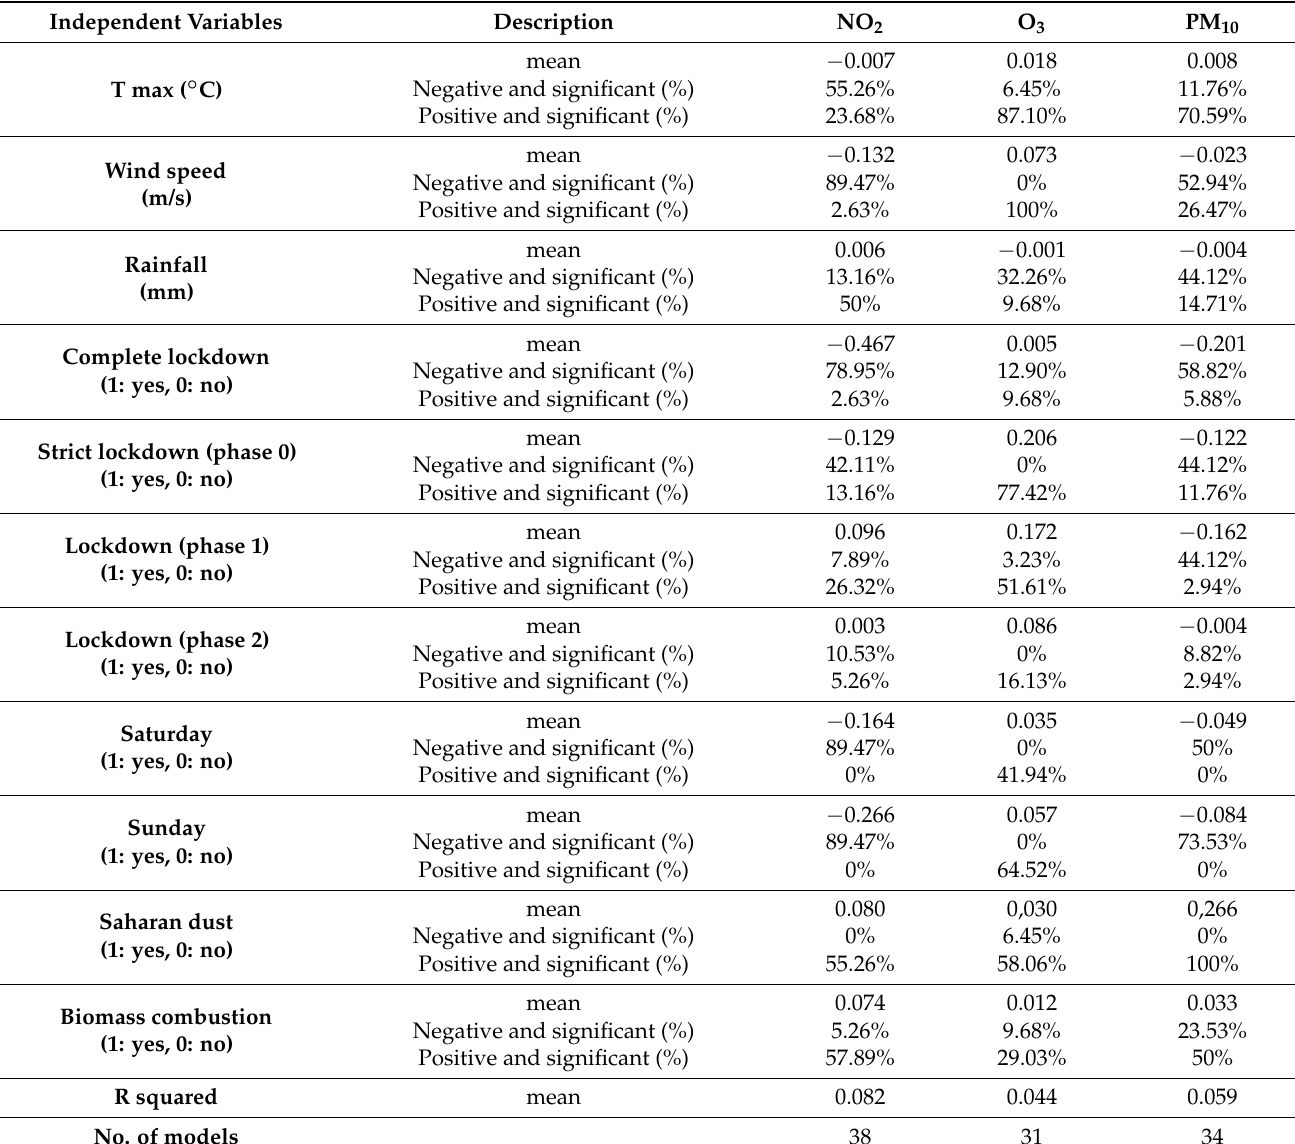
Table 2. Regression results from pollutants. Columns 3 to 5 display the estimated mean coefficients between the regression models of each independent variable (independent variable column) relative to each dependent variable (pollutant) in southwestern